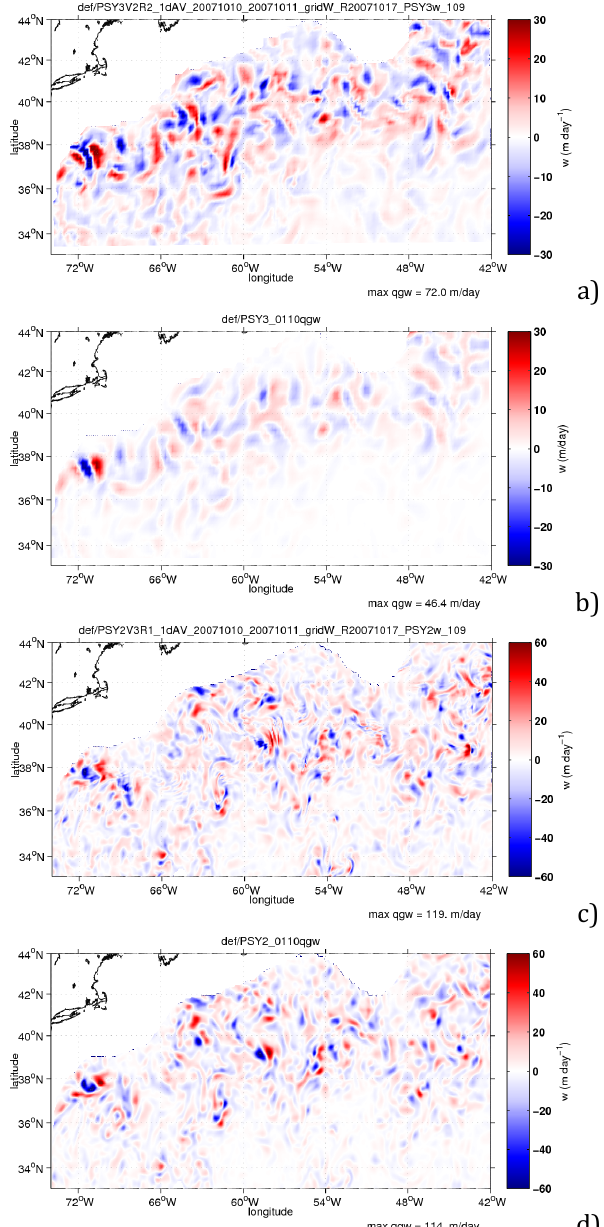
Fig. 11. Vertical velocity fields at 110m as obtained from primi- tive equation (a, c) and quasi-geostrophic omega equation (b, d) for PSY3 1/4 ◦ (a, b) and PSY2 1/12 ◦ (c, d) Mercator